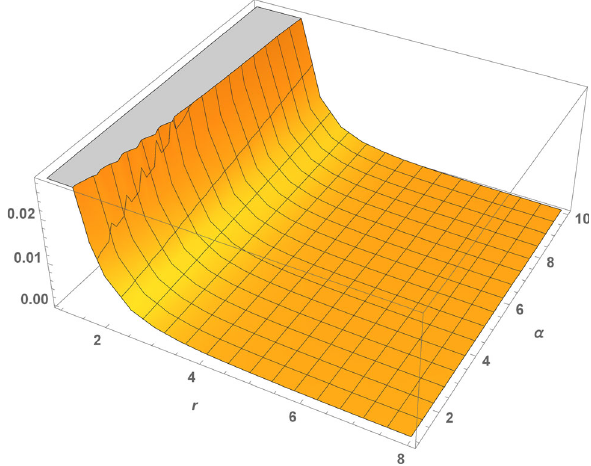
Fig. 10 Validation of DEC, ρ ≥ | p t | , for λ = − 35 and different